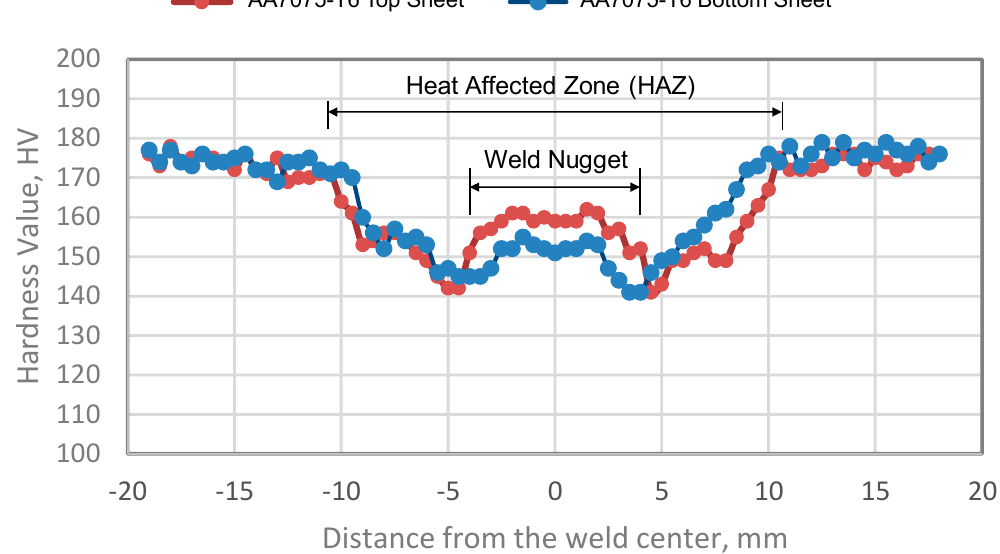
Figure 3. Cross-sectional microhardness map of the refill spot weld. The hardness values are taken from the midplane lines of the top sheet and the bottom sheet of a weld cross-section. The top sheet and the bottom sheet are 1.6 mm-thick AA7075-T6. The base metal hardness value is 175 HV. The refill spot weld diameter is 7 mm.